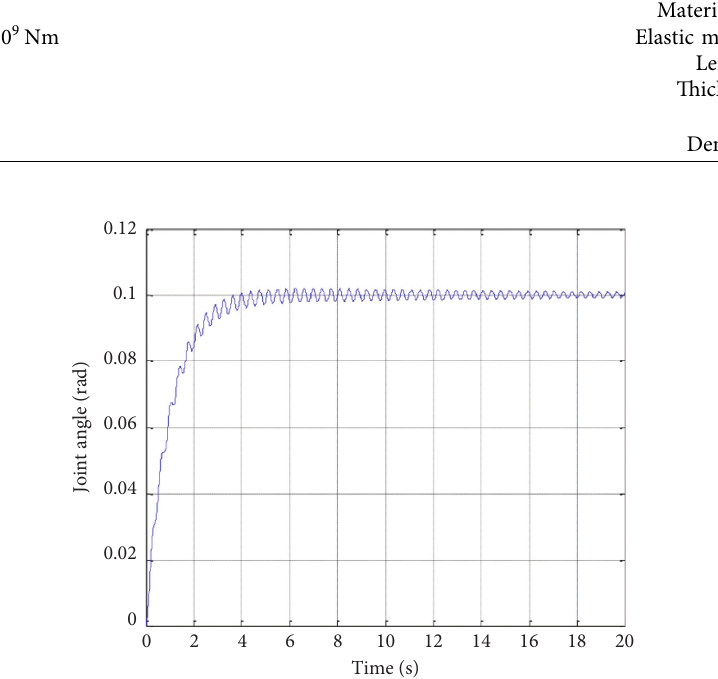
Figure 4: Joint angular displacement of the flexible manipulator with PD control.